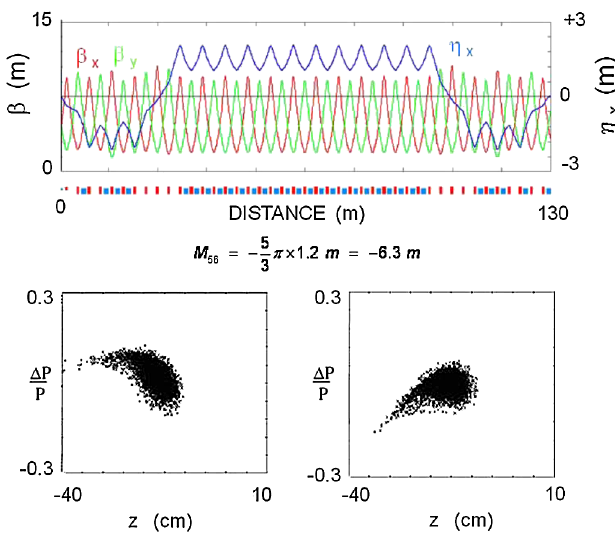
FIG. 11. (Color) Top: Droplet arc optics, showing the uniform periodicity of beta functions and dispersion. Bottom: Particle tracking results showing the longitudinal phase-space compres- sion. The longitudinal phase space ( s , (cid:1) p=p ) is shown at the beginning (left) and at the end (right) of the arc.